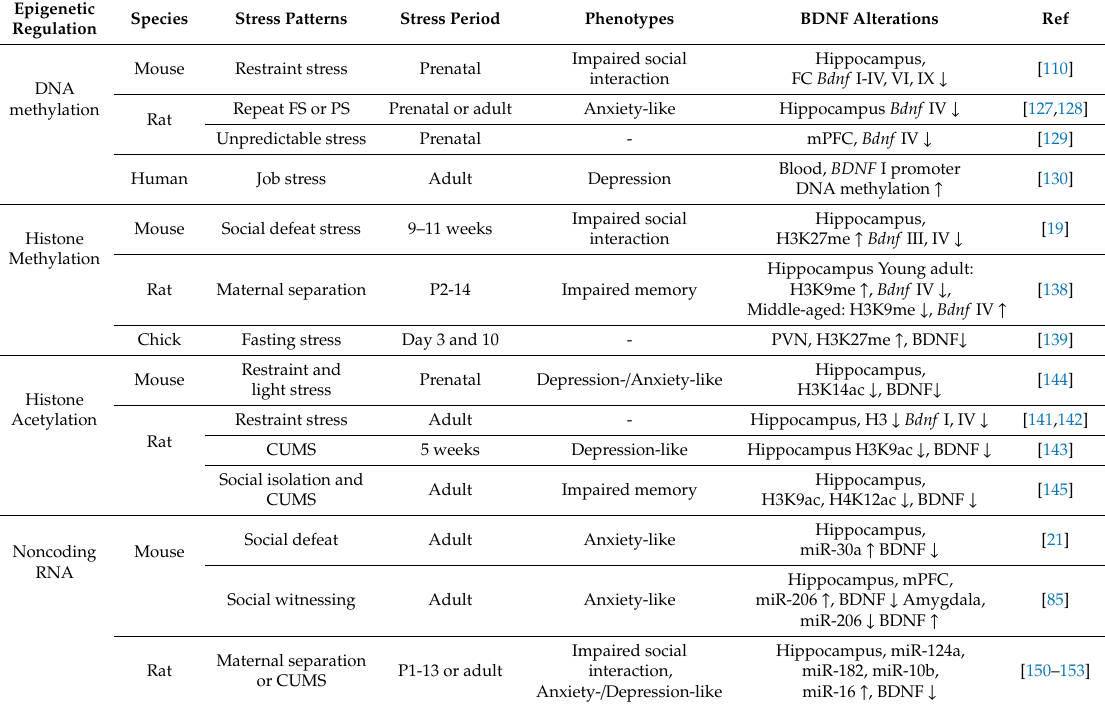
Table 2. Summary of epigenetic regulations on BDNF expression in stress